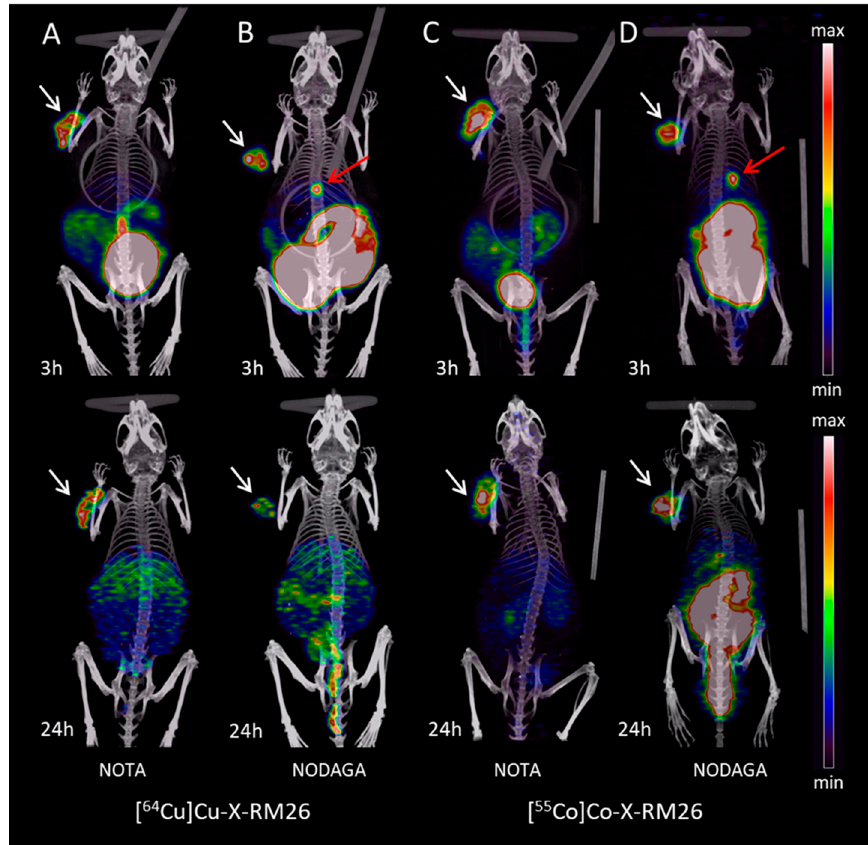
Figure 6. Coronal maximum intensity projection (MIP) preclinical positron emission tomography (PET)/CT images showing tracer distribution in PC-3 xenografted NOD-SCID mice. Uptake and distribution of [ 64 Cu]Cu-X-RM26 are shown in images ( A ) and ( B ) and for [ 55 Co]Co-X-RM26 in images ( C ) and ( D ), (X = NOTA-PEG 2 or NODAGA-PEG 2 ). The mice were scanned at 3 h (top row) and 24 h (bottom row) p.i. The tumor is shown by the white arrow. The gall bladder was visual in both the 3 h NODAGA scans and is shown by the red arrow. The intensity of PET is displayed from zero to maximum of the tumor uptake.